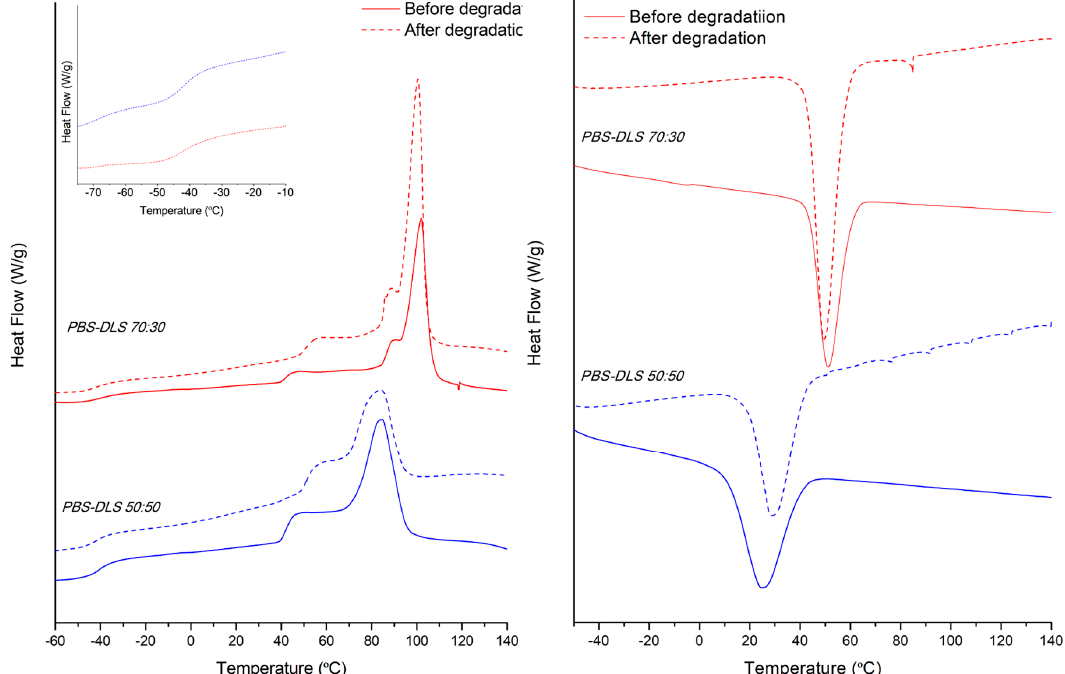
Figure 10. Left : First heating scan of films before (solid line) and after (dashed line) degradation with a T g region detail of degraded samples. Right : Cooling scan of films before (solid line) and after (dashed line) degradation. PBS-DLS 50:50 (blue) and PBS-DLS 70:30 (red) copolymers. Polymers 2018 , 10 , x FOR PEER REVIEW